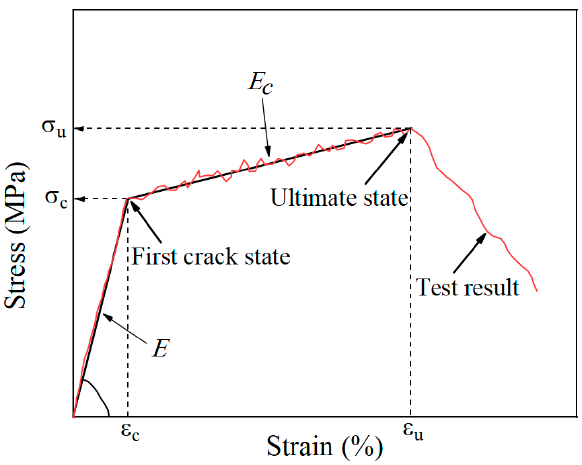
Figure 8. Stress–strain relationship of TR-LECC composites.